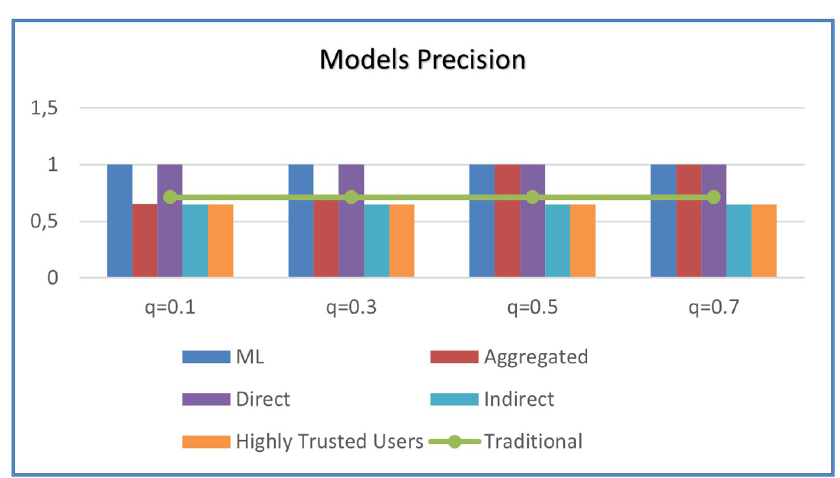
Fig 11. Effect of aggregation weighting factor (q) on prediction precision.